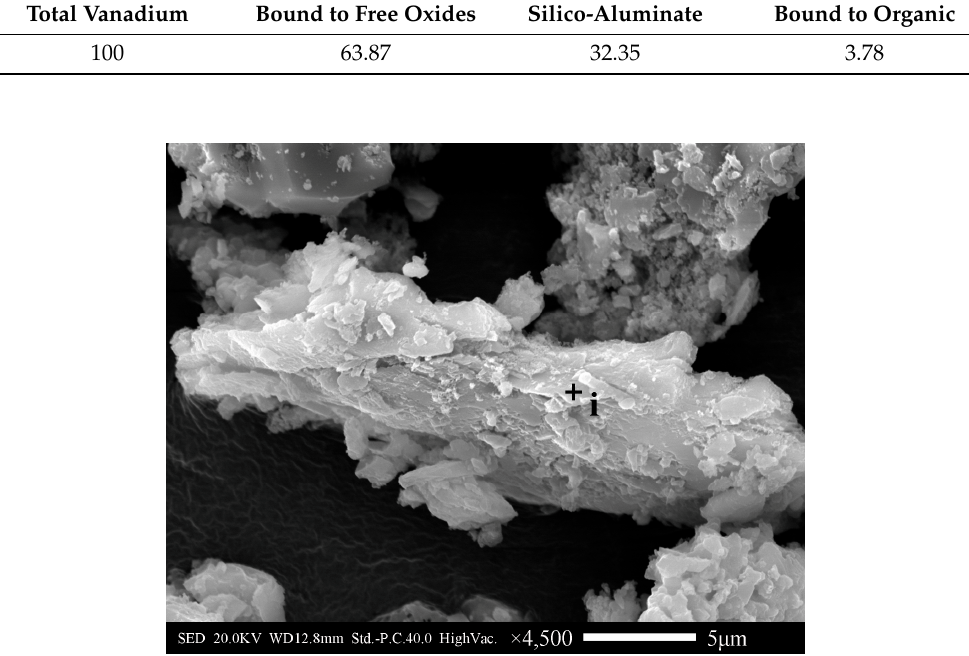
Table 2. Distribution of vanadium in the sample (wt %).